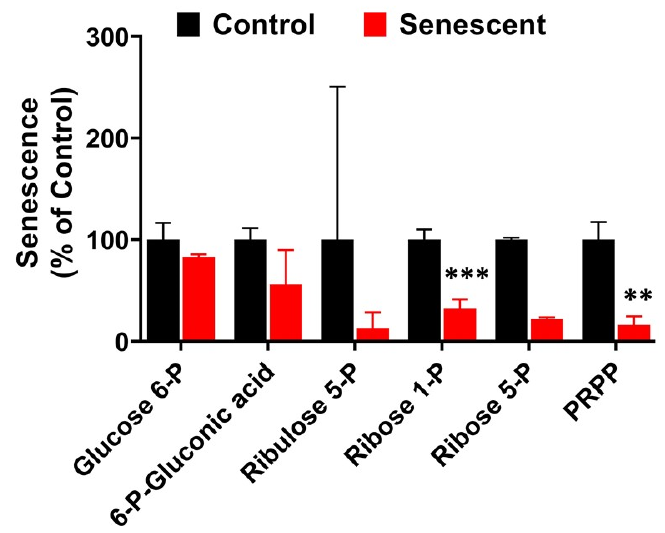
Figure 8. Levels of pentose phosphate pathway-related metabolites in control and senescent HCT-116 cells. Metabolites in senescent cells are expressed as percent of control based on protein concentration of samples. Some metabolites were undetectable in both control and senescent cells. Results are ± SD of triplicate samples. Actual values obtained from analysis (nmoles/g protein) including p values and significance is presented in Table S2. ** p value < 0.01, *** p value <